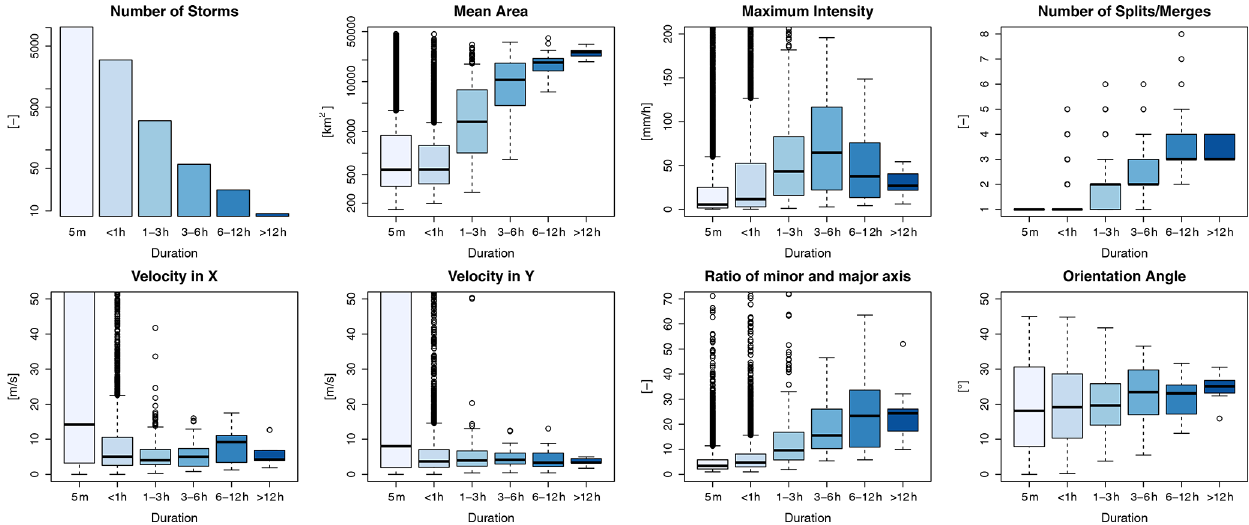
Figure 4. Different properties of the storms recognized from 110 events separated into six groups according to their duration (shown in different shades of